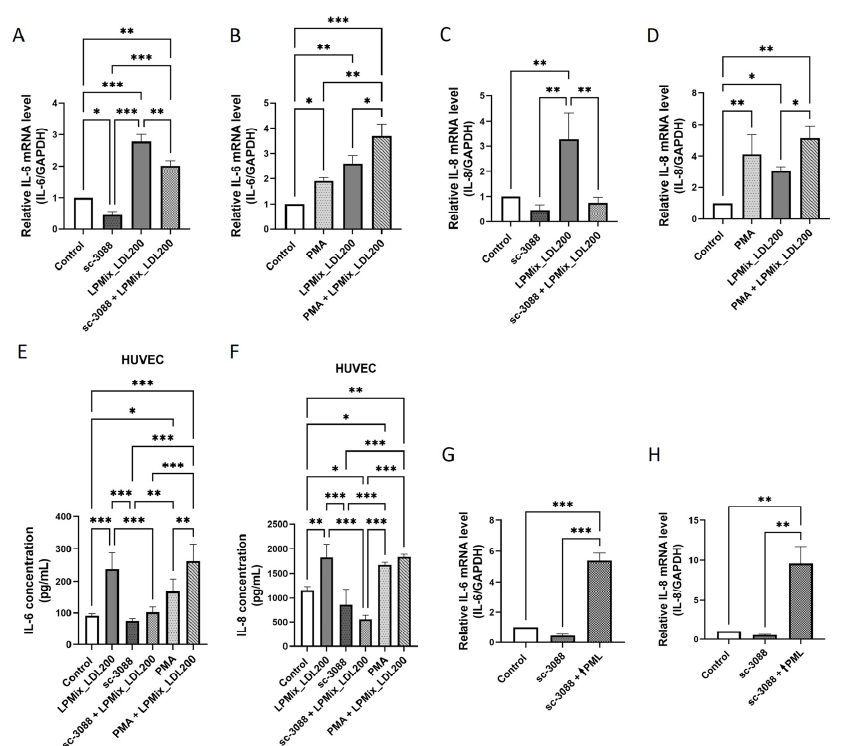
Figure 7. PKC influences LDL-triggered and PML-dependent IL-6 and IL-8 upregulation in endothelial cells. ( A , B ) RT-qPCR was performed on EA.hy926 cell extracts incubated with high LDL concentrations in LPMix with or without sc-3088 (1 µM) for 24 h to determine IL-6 mRNA ( A ) or IL-8 mRNA ( B ) levels. Expression values relative to control. n = 3, two-way ANOVA. ( C , D ) To determine IL-6 ( C ) or IL-8 mRNA ( D ) levels, RT-qPCR was performed on extracts of EA.hy926 cells incubated with high LDL concentrations in LPMix with or without PMA (80 nM) for 24 h. Expression values relative to control. n = 3, two-way ANOVA. ( E , F ) Concentrations of IL-6 ( E ) or IL-8 ( F ) protein in supernatants of HUVECs incubated with high LDL concentrations in LPMix with or without sc-3088 (1 µM) or PMA (80 nM) treatment for 24 h, as quantified by ELISA. n = 3, two-way ANOVA. ( G , H ) RT-qPCR for the quantification of IL-6 ( G ) or IL-8 ( H ) mRNA levels in EA.hy926 cells transfected with an EGFP-C1-PML-IV-vector in the absence/presence of sc-3088 (1 µM) for 24 h. Expression values relative to control. n = 3, two-way ANOVA All graphs shown as mean ± SD, * p < 0.05, ** p < 0.01, *** p < 0.001.